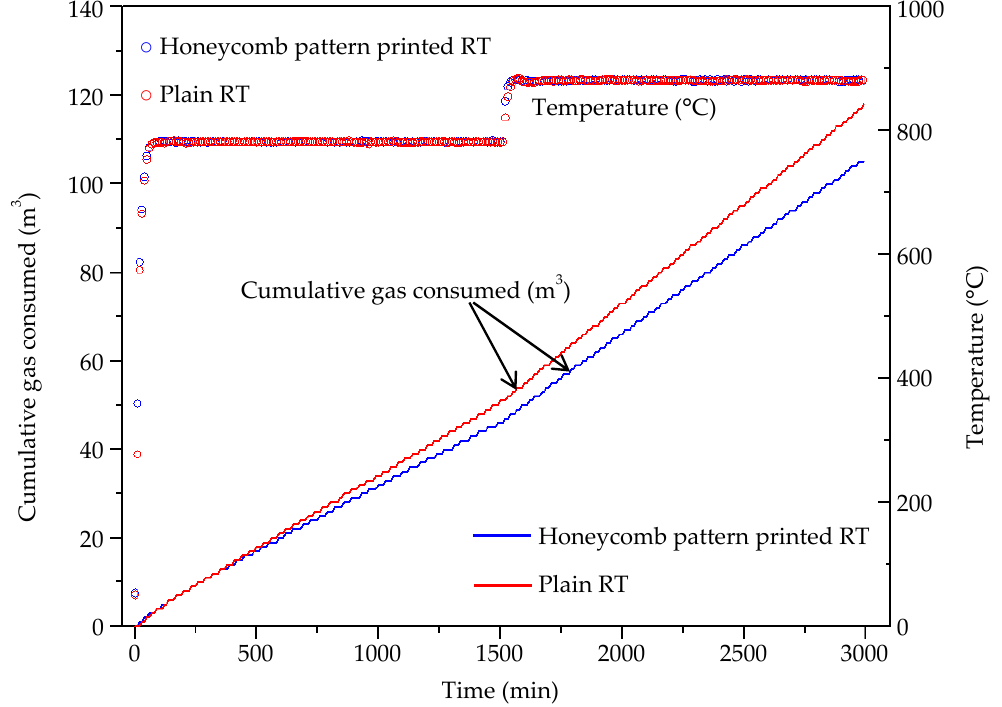
Figure 12. Measured temperature and cumulative gas consumed for plain (no honeycomb pattern printed) and honeycomb pattern printed RT.